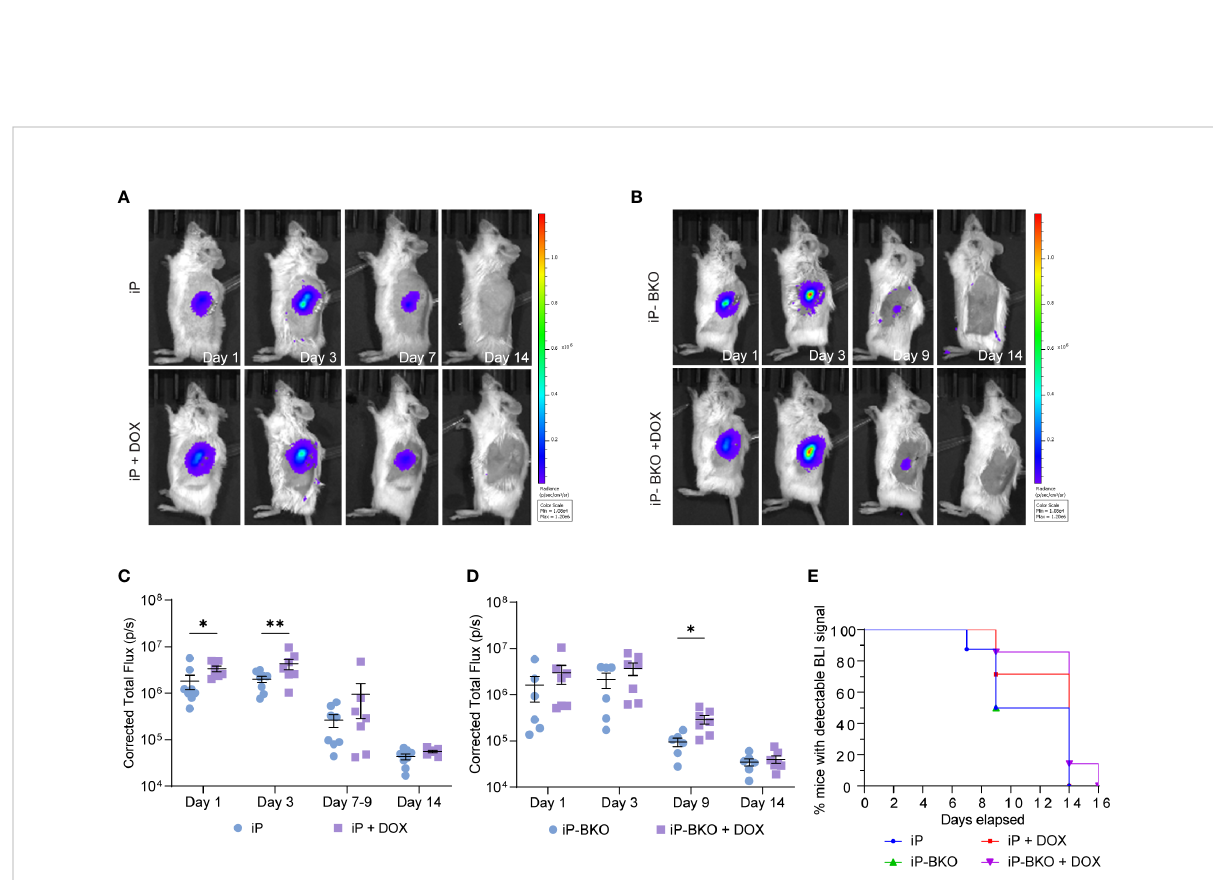
FIGURE 3 Longitudinal monitoring of the sBC graft by transdermal bioluminescence detection via IVIS. (A, B) Representative images of bioluminescence expression by (A) iP-sBC or (B) iP-BKO sBC graft after transplant on day 1, 3, 7 or 9, and 14. (C, D) Quanti fi cation of the total fl ux measured from mice of both sex in the (C) iP-sBC and (D) iP-BKO sBC experiments. Each sBC group is subdivided by +/- DOX treatment as follows: iP (n=7), iP + DOX (n=8), iP-BKO (n=6) and iP-BKO + DOX (n=7). Two-Way ANOVA, *p < 0.05, **p-value < 0.01 mean ± s.e.m. (E) Kaplan-Meier curve for percentage of mice with detectable bioluminescence signal for all groups.